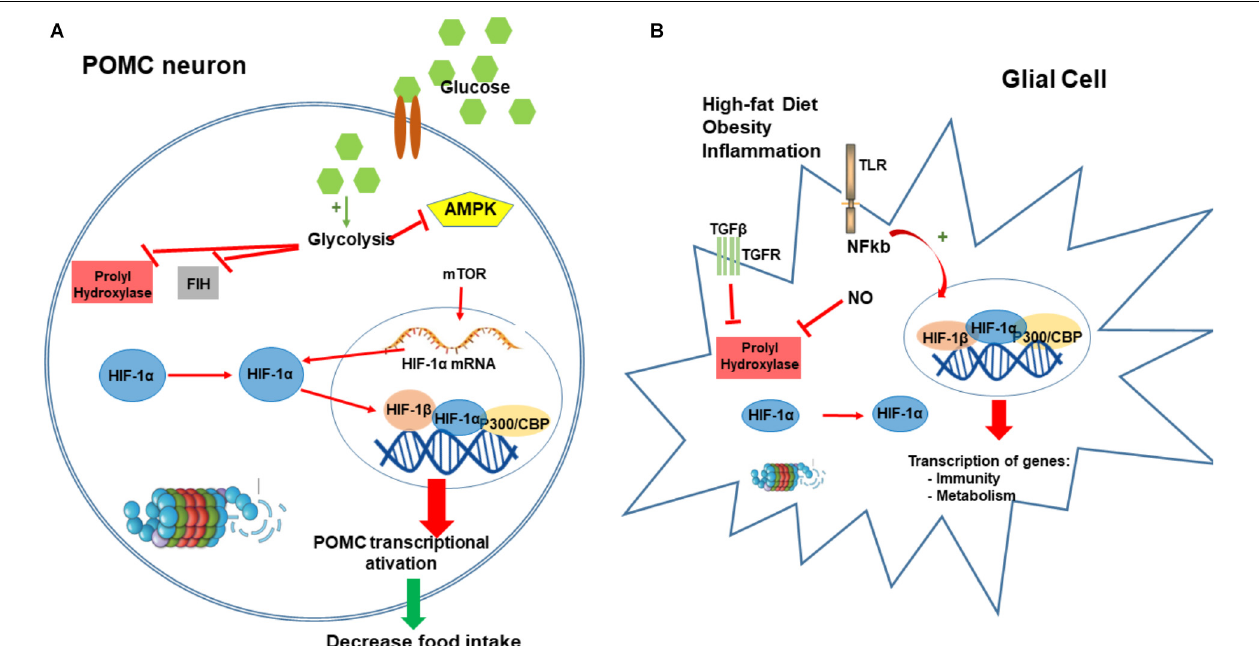
FIGURE 3 | Hypoxia-inducible factor-1 regulation of food intake. HIF in POMC neurons can function as a glucose sensor. After a meal, the increase in neuronal concentration activates neuronal glycolysis producing pyruvate, lactate, and intermediaries from the tricarboxylic acid (TCA) cycle. These metabolites inhibit PHD and FIH enzymes leading to the HIF stabilization. Conversely, these metabolites also block AMPK activation that regulates and increase the expression of HIF- α mRNA. Increase in HIF induces its translocation to the nucleus to bind POMC promoter and consequently stimulating the transactivation of POMC (A) . Obesity and consumption of high-fat diet induces an inflammatory condition in the hypothalamus, mostly driven by microglia and glial cells. Our main hypothesis is that inflammation in hypothalamic glial cells (increased TGF- β , TLR4 signaling, and increased NO production) leads to a stabilization of HIF that consequently transactivates several genes involved in the regulation of metabolism and inflammatory process as a compensatory mechanism for the nutritional excess (B) . CBP/p300, Creb Binding Protein/p300; PHD, prolyl hydroxylases; FIH-1, factor inhibiting HIF-1; AMPK, 5’ AMP-activated protein kinase; POMC,